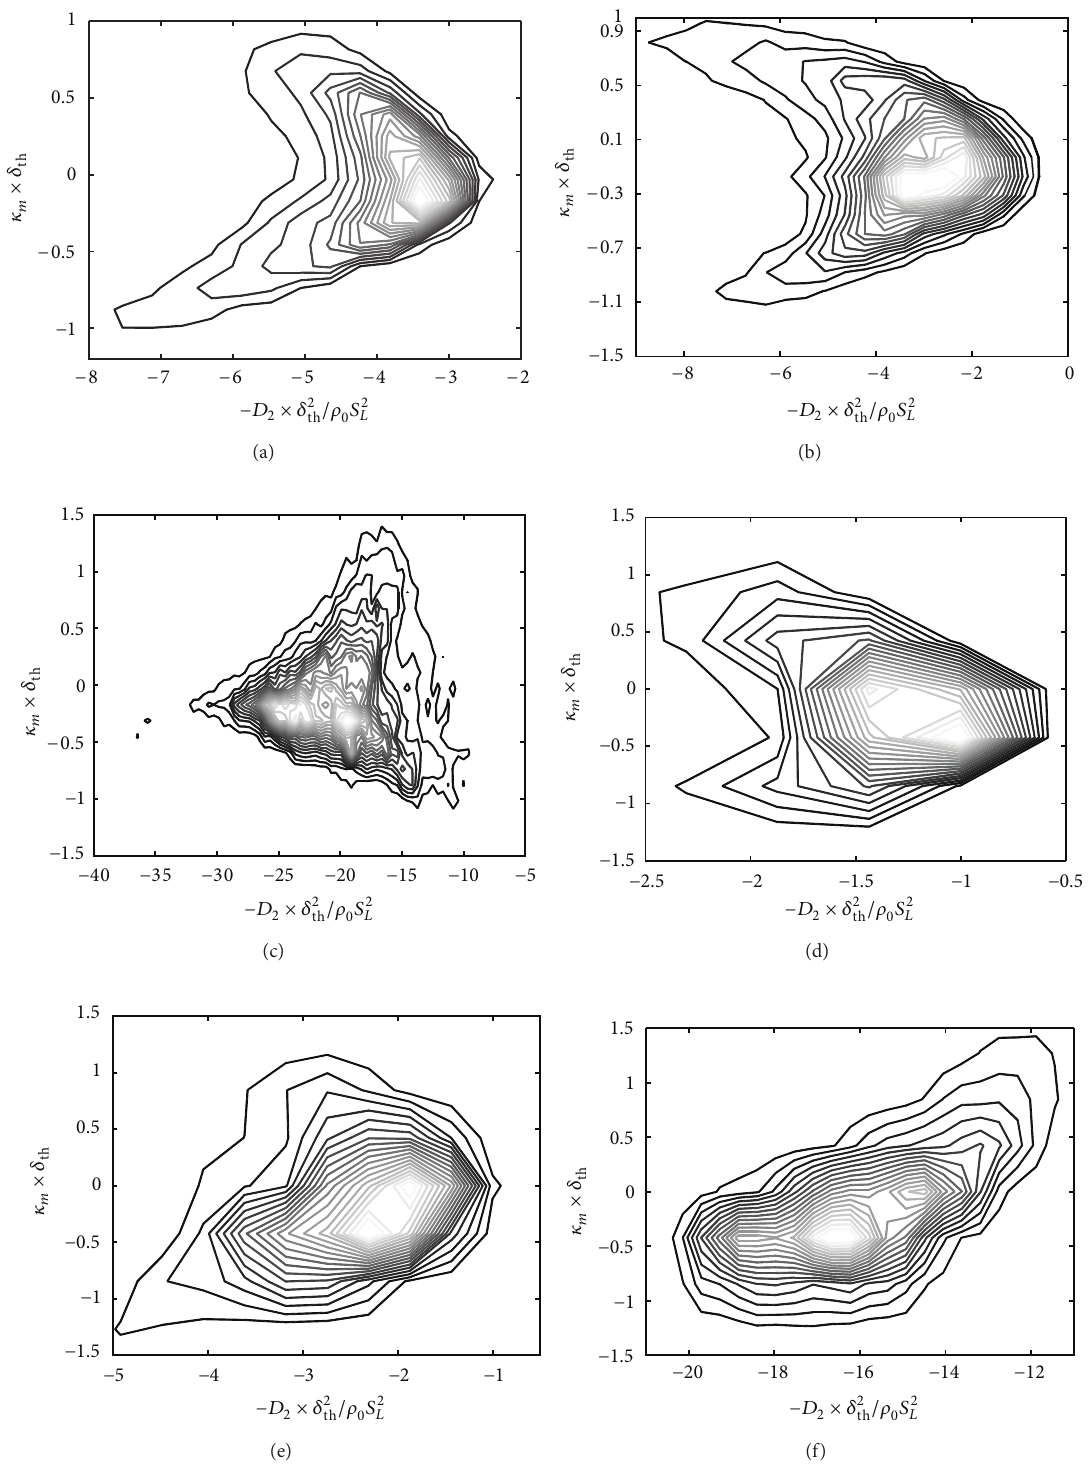
/𝜌 𝑆 2 0 𝐿 and normalised curvature th